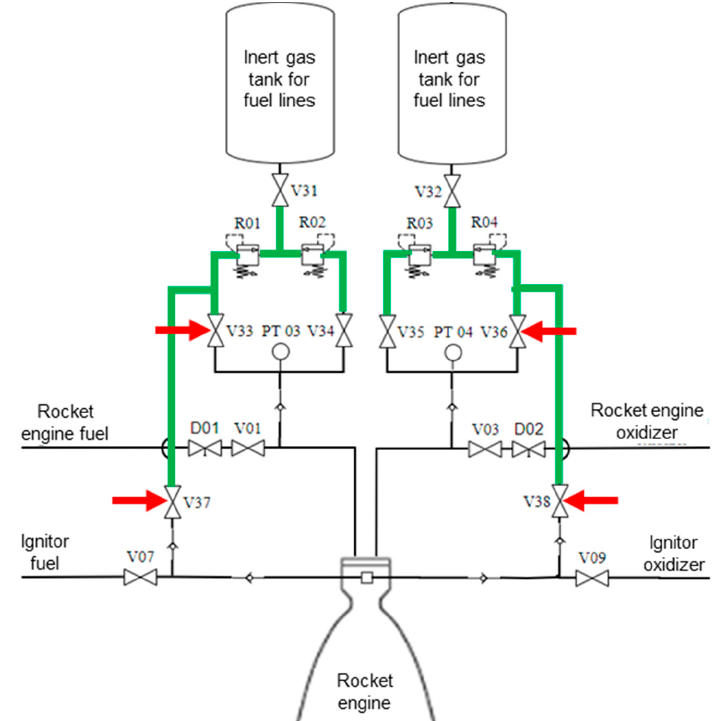
Figure 19. Algorithm’s sixth step diagram.